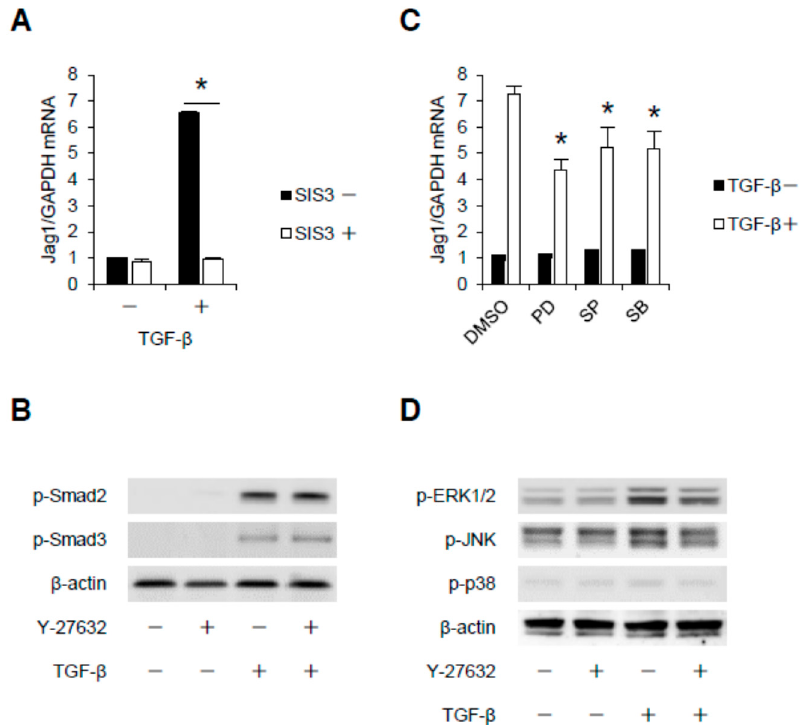
Figure 3. Mitogen-activated protein kinases (MAPKs) are signaling intermediates required for Rho-kinase-mediated Jag1 induction. ( A ) Differentiated E11 podocytes were pretreated with Smad3 inhibitor (SIS3, 10 µ M) and then stimulated with TGF- β (5 ng/mL) for 8 h. Jag1 mRNA was analyzed by real-time quantitative PCR; ( B ) Podocytes were pretreated with Y-27632 (10 µ M) before stimulation with TGF- β (5 ng/mL) for 30 min. Cell lysates were subjected to Western blotting. A representative blot of three independent experiments is shown; ( C ) Podocytes were stimulated with TGF- β for 8 h with or without pretreatment of MAPK inhibitors (50 µ M). RNA was extracted, and Jag1 mRNA was analyzed by real-time quantitative PCR, with GAPDH mRNA as the internal standard. * p < 0.05 vs. DMSO with TGF- β ; ( D ) Podocytes were pretreated with Y-27632 (10 µ M) and then stimulated with TGF- β (5 ng/mL) for 30 min. Equal amounts of cell lysate were subjected to Western blotting using MAPKs antibodies. A representative blot of three independent experiments is shown. The data are presented as means ± SD.